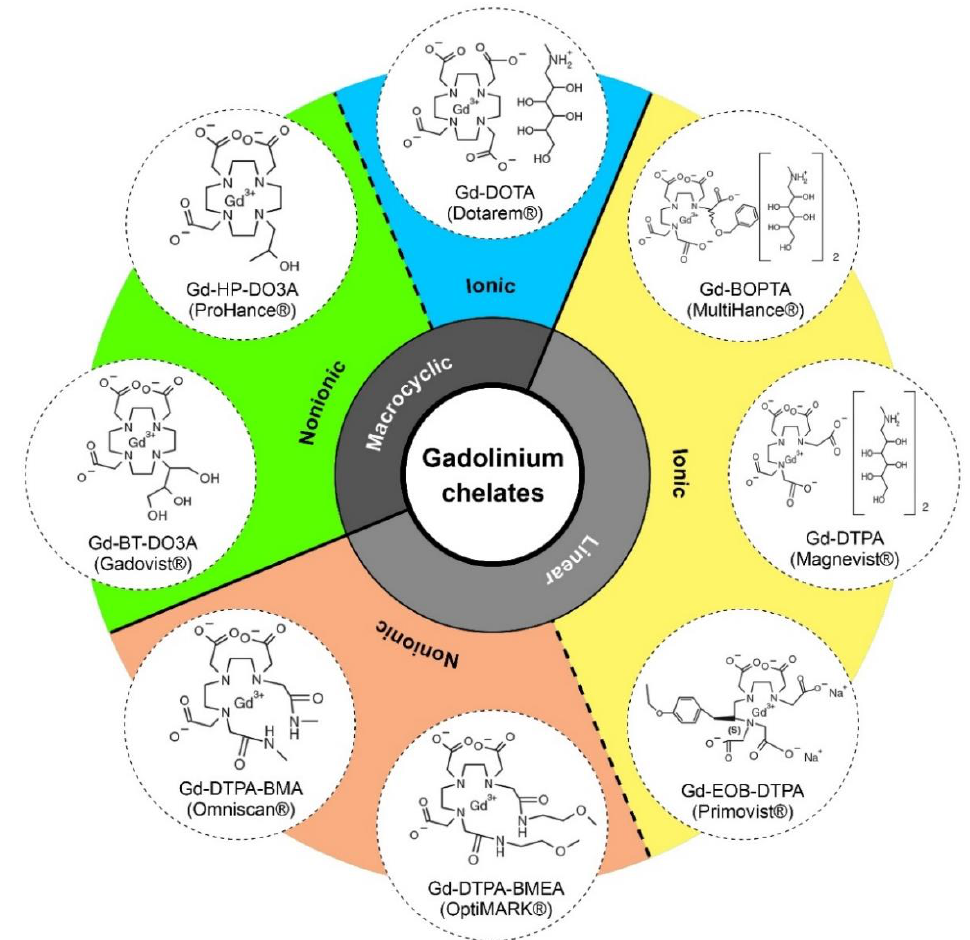
Figure 3. Structure of currently marketed Gd-CAs used for MRI [102].